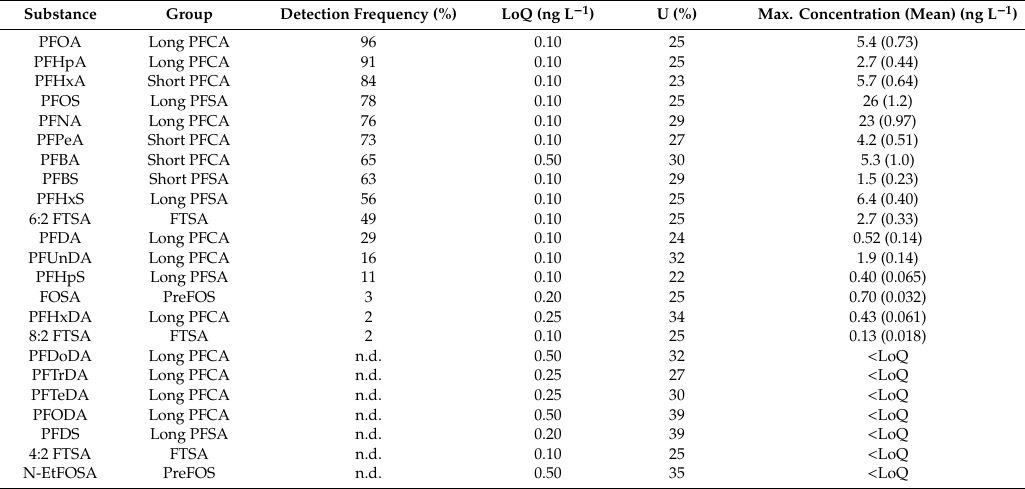
Table 3. Summary of PFAS detection frequencies and concentrations in sampled surface